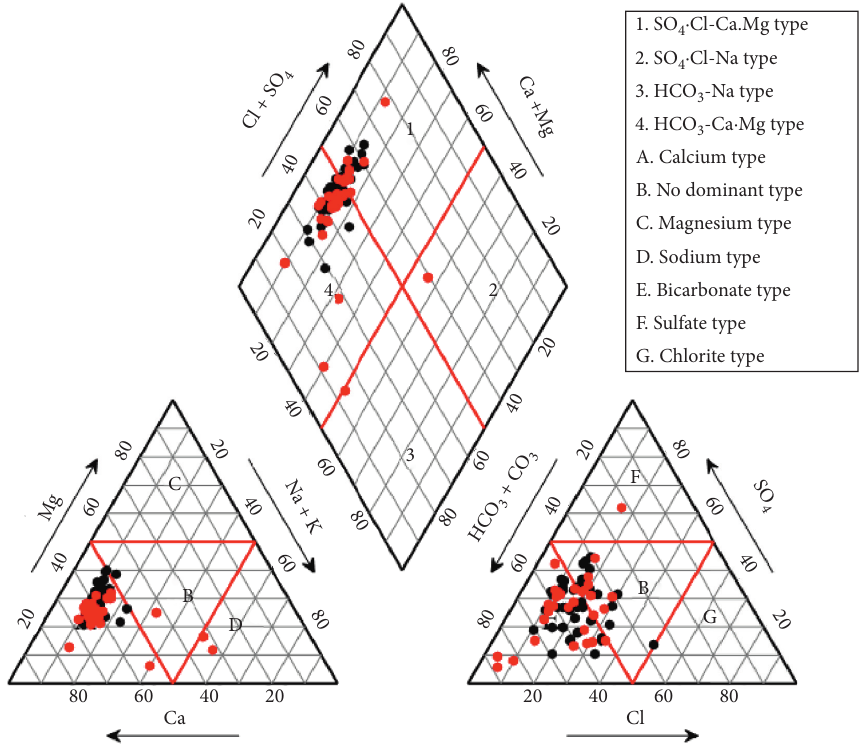
Figure 5: Piper diagram of groundwater samples.